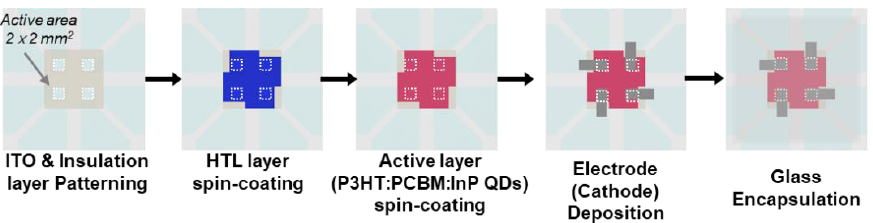
Figure 2. Fabrication sequence of InP QDs contented with P3HT:PC 70 BM active layer for radiation detector.